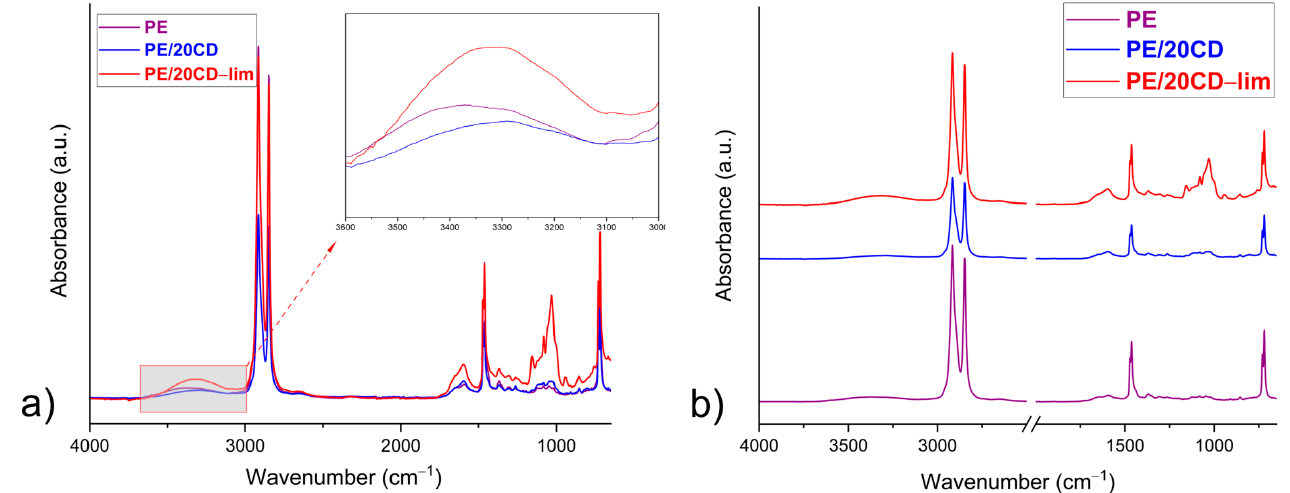
Figure 2. FTIR-ATR of PE (purple curve), PE/20CD (blue curve), and PE/20CD-lim (red curve) for overlapped ( a ) and stacked ( b )